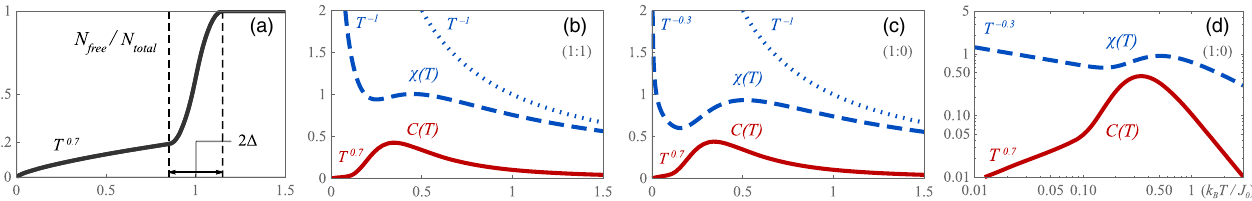
FIG. 6. Susceptibility χ ð T Þ and specific heat C ð T Þ in a simple two-regime model. (a) The model is defined by a temperature-dependent =N function N , the fraction of singlets/triplets with energy less than k free total window J 0 (cid:2) Δ ( Δ ¼ 0 . 15 J 0 ), while remaining 20% sites form singlets and triplets with ratio 1 ∶ 1 (b) or 1 ∶ 0 , i.e., only singlets (c),(d), with energy distribution T α with α ¼ 0 . 7 . (b) – (d) Linear and log-log plots of magnetic susceptibility χ ð T Þ (dashed blue) [cf. free spin χ ð T Þ ¼ 1 =T (dotted blue)] and specific heat C ð T Þ (red) in the spin-pair approximation. Units are J μ 2 =k J 0 for χ ð T Þ and k for C ð T Þ . While χ ð T Þ is sensitive to emergent FM bonds (b), C ð T Þ ∼ T α is B B B